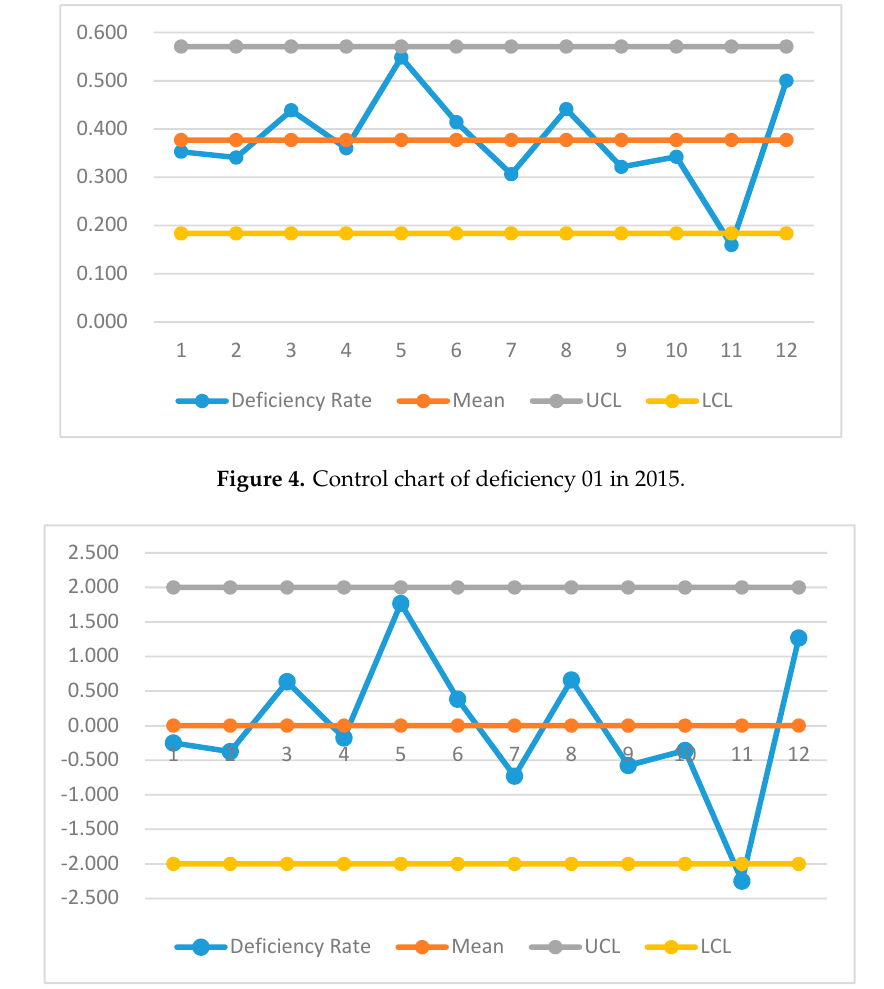
Figure 5. Normalized control chart of deficiency 01 in 2015.